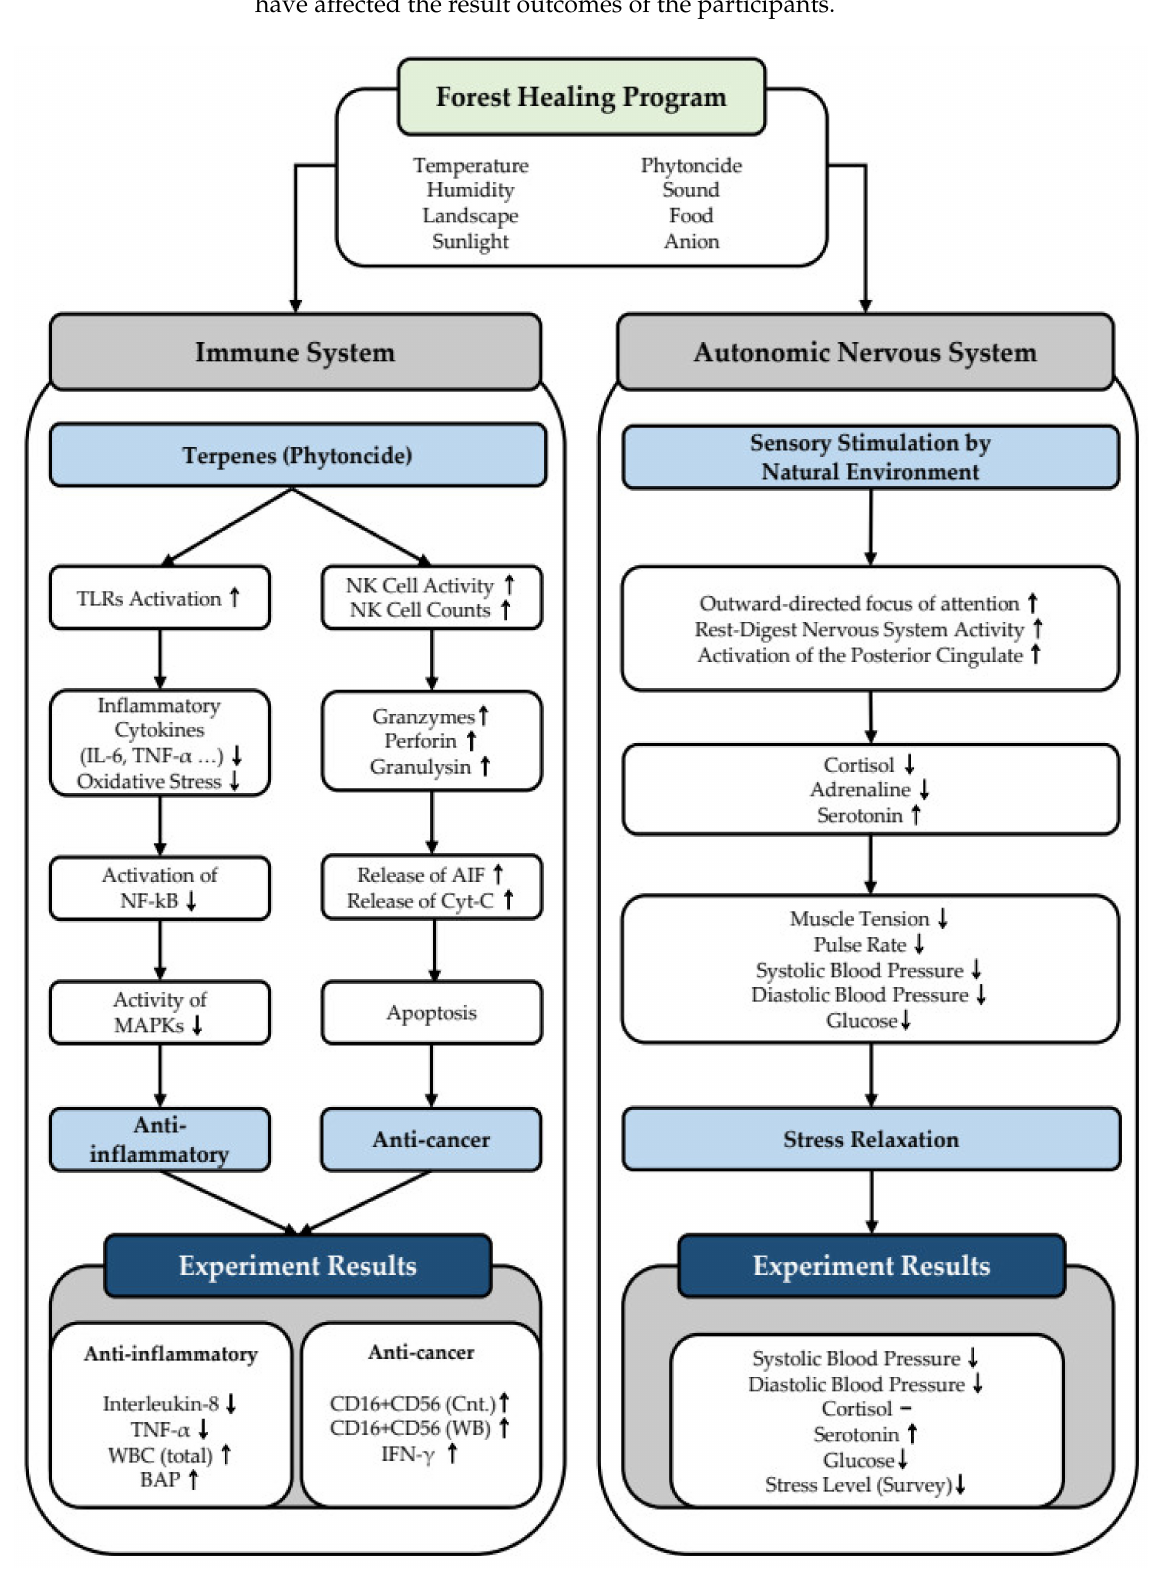
Figure 11. Mechanism of the forest healing program. TLRs: Toll-like receptors; NF-kB: nuclear factor kappa-light-chain- enhancer of activated B cells; AIF: apoptosis-inducing factor; Cyt-C: cytochrome